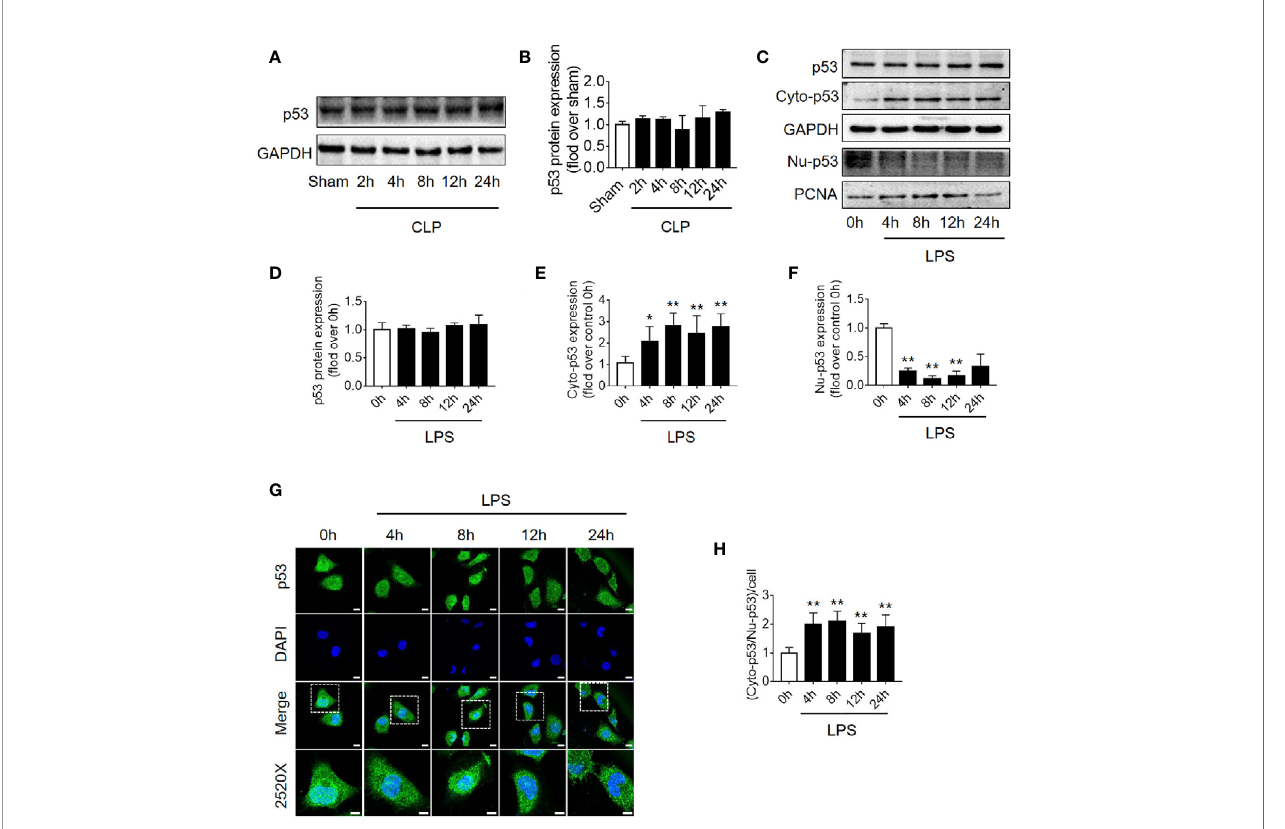
FIGURE 4 | p53 protein expression and intracellular distribution. (A) Representative western blot showing p53 protein levels in the renal cortex following CLP- induced sepsis. GAPDH was used as an internal reference. (B) Densitometric analyses of p53 protein expression. n = 3. (C) Representative western blot showing p53 protein levels in HK-2 cells following LPS treatment. GAPDH was used as an internal control of p53 total protein and cytoplasmic protein levels, and PCNA was used as an internal control for nuclear proteins. (D – F) Densitometric analyses of p53 total protein level, cytoplasmic protein level (cyto-p53), and nuclear protein level (Nu-p53). n = 3-5. * p < 0.05, ** p < 0.01 vs. the 0 h group. (G) Representative cellular immuno fl uorescence observation of p53 in the nucleus and cytoplasm after LPS stimulation. p53 was labeled with green fl uorescence using FITC, and the nucleus was labeled with blue fl uorescence by DAPI. The magni fi cation of the upper panel is 630×, and the magni fi cation of the bottom panel is 2520×. Scale bar, 10 µm. (H) The ratio of the fl uorescence intensity of cytoplasm p53 to nucleus p53 in each cell. ** p < 0.01 vs. the 0 h group. Results represent at least three independent experiments. CLP, cecal ligation and puncture; GAPDH, glyceraldehyde 3- phosphate dehydrogenase; LPS, lipopolysaccharide; PCNA, proliferating cell nuclear antigen; FITC, fl uorescein isothiocyanate; DAPI, 4 ’